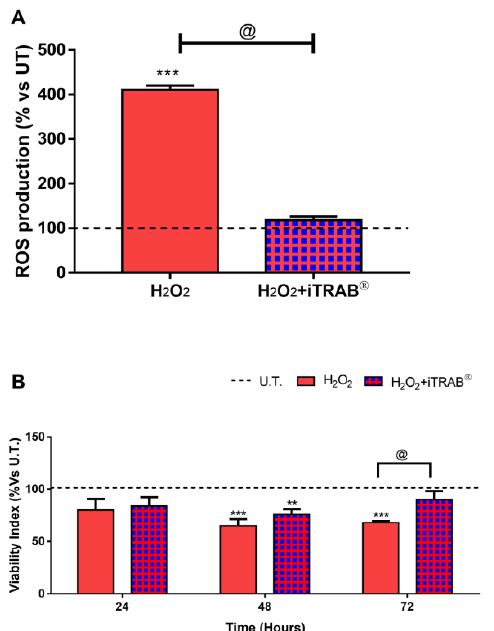
Figure1. Reactiveoxygenspecies(ROS)ProductionandViability. ( A )ROSproduction. Dichlorofluorescein Figure 1. Reactive oxygen species (ROS) Production and Viability. ( A ) ROS (DCF) assays were performed after 2 h of experimental procedures. ( B ) Viability index. Viability indices production.Dichlorofluorescein (DCF) assays were performed after 2 h of experimental procedures. were performed by Alamar blue assay. Data areexpressed as % vs. untreated (U.T) 3D-human trabecular ( B ) Viability index.Viability indices were performed by Alamar blue assay. Data areexpressed as % meshwork cells (3D-HTMCs) and represent the mean ± standard deviation (SD) of 3 independent vs. untreated (U.T) 3D-human trabecular meshwork cells (3D-HTMCs) and represent the mean ± experiments. *** , ** treated 3D HTMCs vs. UT; @ H 2 O 2 -treated vs. H 2 O 2 + iTRAB-treated 3D HTMC. standard deviation (SD) of 3 independent experiments. *** , ** treated 3D HTMCs vs. UT; @ H 2 O 2 - *** / @ p < 0.001;** p < 0.01 (Two-way ANOVA followed by Bonferroni’s treated vs. H 2 O 2 +iTRAB-treated 3D HTMC. *** /@ p < 0.001;** p < 0.01 (Two-way ANOVA followed by Bonferroni’s test).